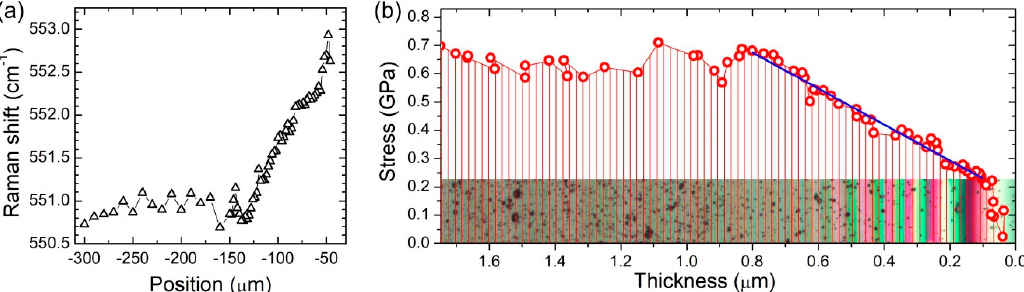
Figure 4. Variation of Raman shift and stress in the depositional edge zone of the Cr 2 O 3 coating. ( a ) Variation of Raman shift with the measurement position; ( b ) Variation of residual stress with coating thickness.